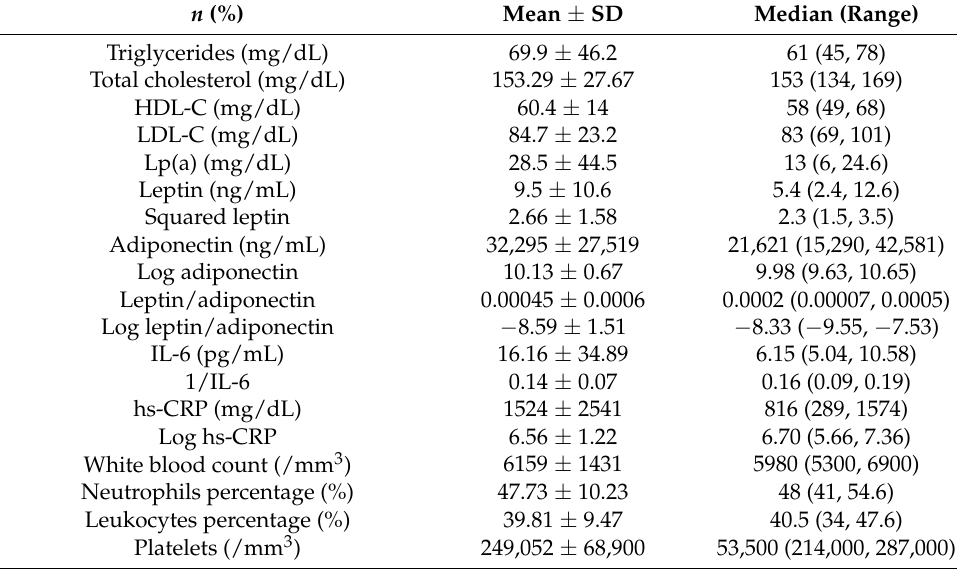
Table 2. Biochemical and hematological parameters of study